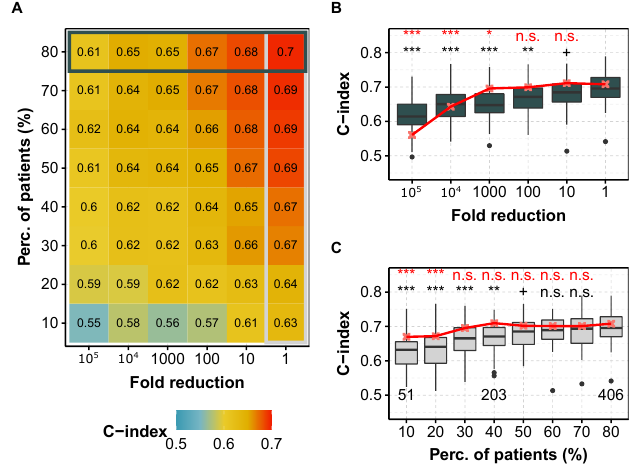
Figure 1. C-index obtained for different fold reduction factors and percentage of patients in the training dataset for KIRC (ccRCC, TCGA) with the Cox model. ( A ) Median C-index for different degradation of both sequencing depth (x axis) and percentage of patients (y axis) in the training dataset for miRNA-seq data. Horizontal box highlights the case where all 80% of patients are used and corresponds to ( B ), whereas vertical box focuses on the full available library size and corresponds to ( C ). ( B ) C-index for different fold reduction factors for miRNA-seq (gray boxplots) and mRNA-seq data (median values, in red) with 80% of the patients in the training dataset. Above is the p -value of a one-sided Wilcoxon test compared to no subsampling (i.e., δ = 1). ( C ) C-index for different percentages of patients in the training dataset for miRNA-seq (light gray boxplots) and mRNA-seq data (median values, in red) with original TCGA sequencing depth. Above is the p -value compared to the full dataset (i.e., 80%). red, mRNA-seq; gray boxplots, miRNA-seq. In each case, we computed the C-indices by 10 repetitions of 5-fold cross validation. ***: p ≤ 0.001, **: p ≤ 0.01, *: p ≤ 0.05, +: p < 0.1, n.s.: p ≥ 0.1. Table 2. Maximum miRNA-seq library size reduction before the decreasing of prediction performance, corresponding median sequencing depth (in thousands of aligned reads), and prediction metric degraded first, for the Cox model, and the 11 investigated cancers.